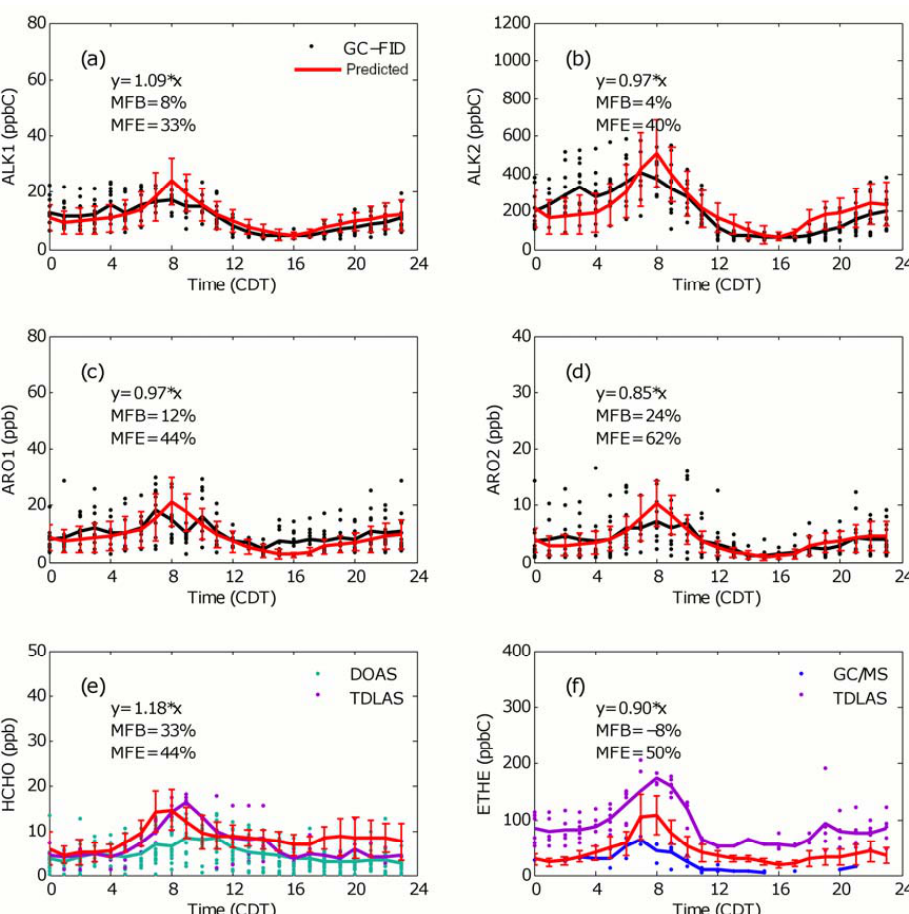
(Fig. 3) Fig. 3. Comparisons of simulated and observed VOC concentrations after the emissions were adjusted. (a) ALK1, (b) ALK2, (c) ARO1, (d) ARO2 at CENICA, and (e) HCHO, (f) ETHE at T0. Measurements within 5 and 95 percentiles are included. Each colored dot indicates individual VOC measurement, and the solid line with corresponding color indicates the average of those measurements. Different color indicates different measurement techniques: GC-FID data in black, DOAS data in light green, QC-TILDAS data in purple, GC and GC/MS data in blue. Hourly averaged simulated VOC concentrations with ± 1 standard deviation (averaged over the time concurrent to the VOC observations at CENICA and T0 in March 2006) are shown in red. Also shown are the agreement statistics ( y =simulations, x =observations) during 6–11